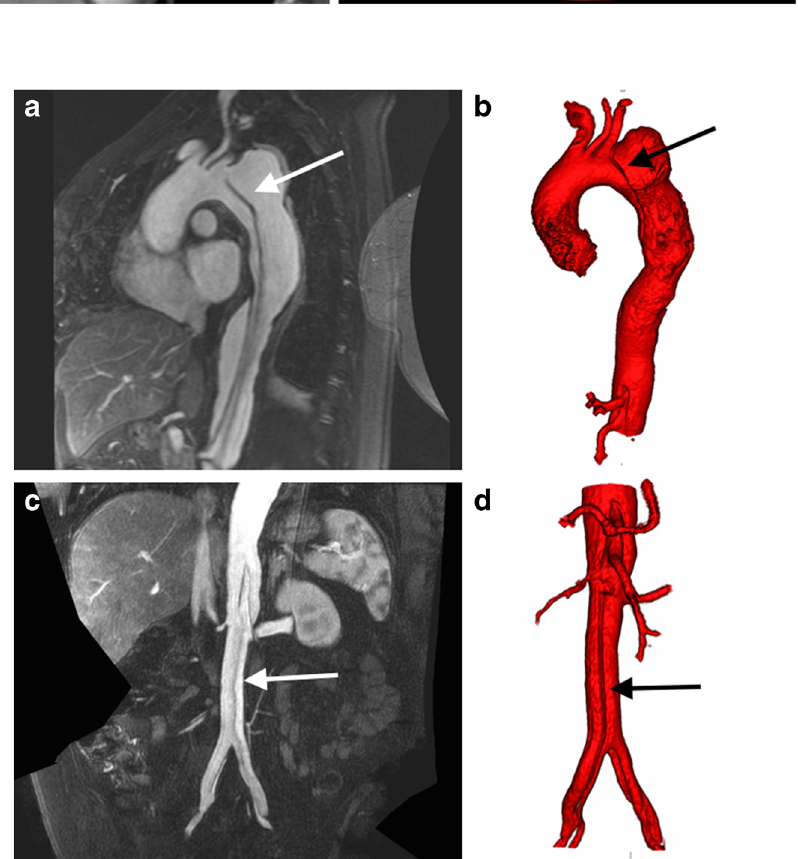
Fig. 5 Axial ( a,b ) and sagittal ( c ) arterial phase images from an ECG-gated CT thoracic aorta an- giogram in a 62-year-old woman with chest pain demonstrates a type A dissection in the ascending thoracic aorta ( a-c , arrow ) with evidence of prior stent graft repair of the descending thoracic aorta ( a-c , curved arrow ). Three- dimensional segmented VR im- age of the thoracic aorta ( d ) de- lineates the ascending aorta dis- section flap ( arrow ) and descend- ing thoracic aorta stent graft ( curved arrow )